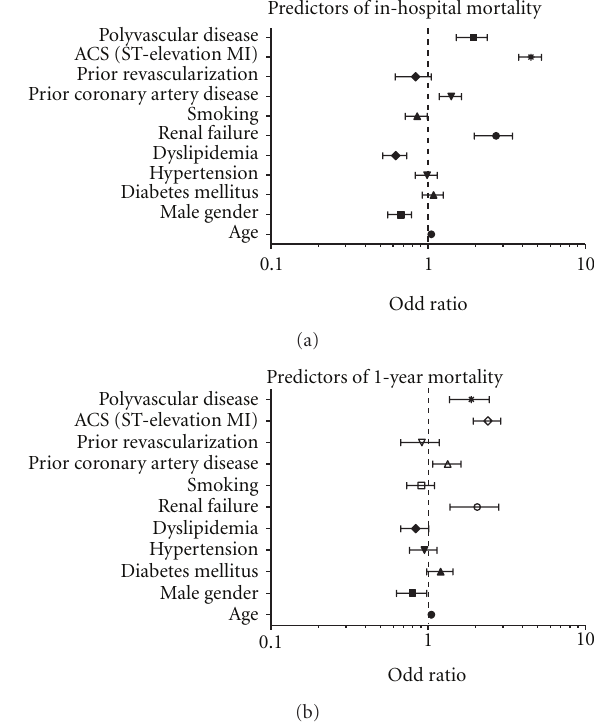
Figure 2: Clinical predictors for in-hospital and 1-year mortality.